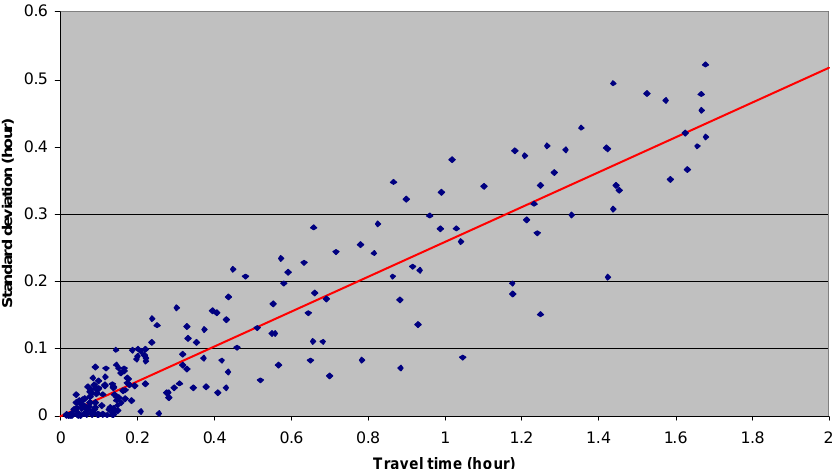
Figure 2. Plot of travel time versus standard deviation of travel time from main road network data source: RAND Europe,